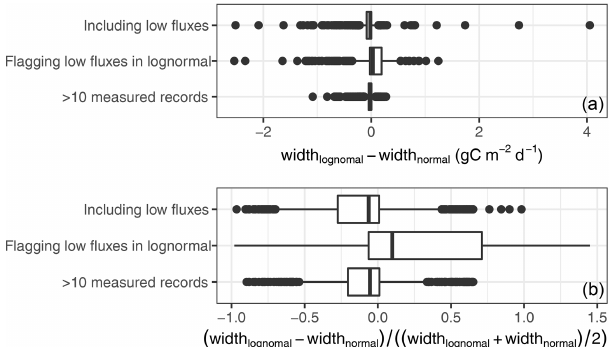
Figure 4. The difference in width of the 95% prediction intervals for daily aggregates between distributional assumption is shown by box plots on an absolute scale (a) and relative scale (b) . Ranges differed only for a few cases as indicated by the outliers dots out- side the (degenerate) boxes. Most of these differences were due to very low fluxes or days with few original measurements, and they disappeared when removing problematic observations (see text) as indicated by the box plots in the second and third